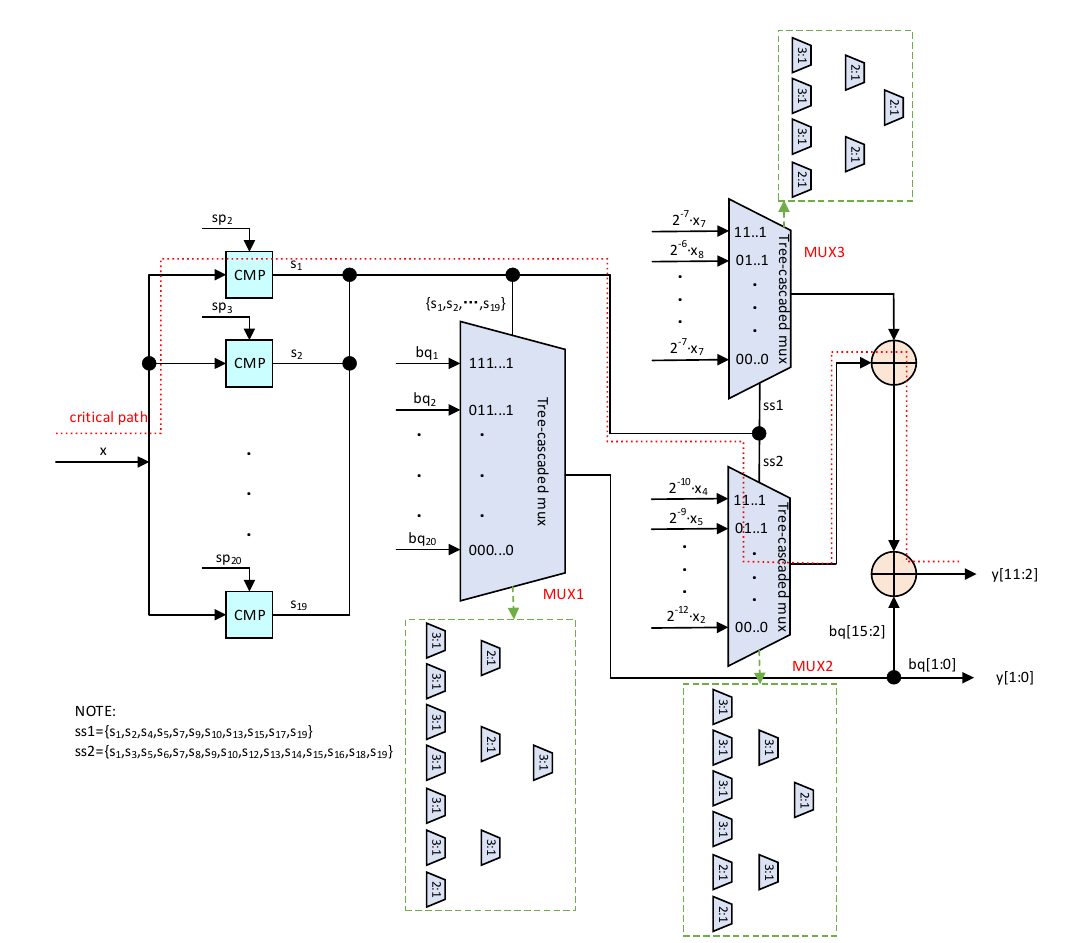
Figure 6. The hardware architecture for softsign(x) (iw = 12, qw = 10, kw = 2, MAE def = 3.91 × 10 − 3 ).